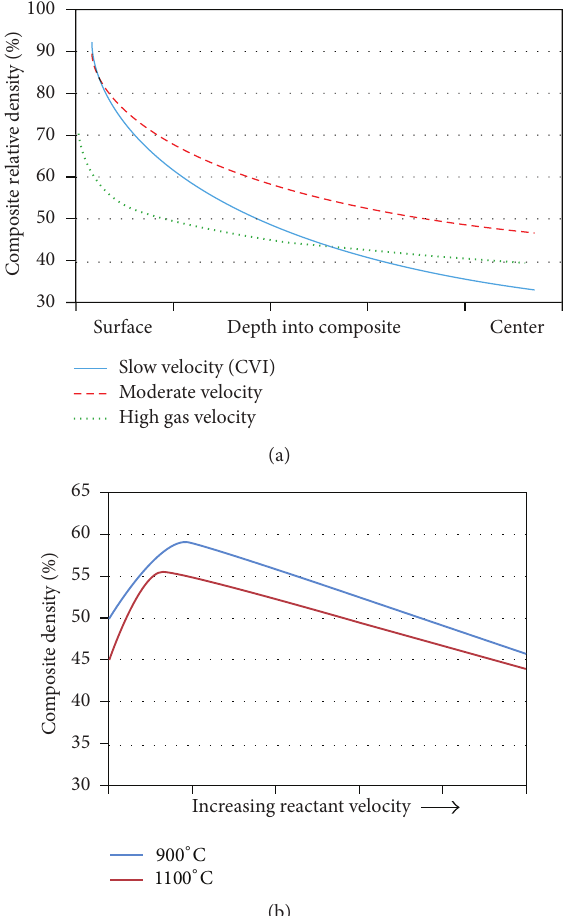
Figure 6: (a) Simulated deposition gradient for varying reactant velocities and (b) variation in simulated composite density as a function of temperature and reactant